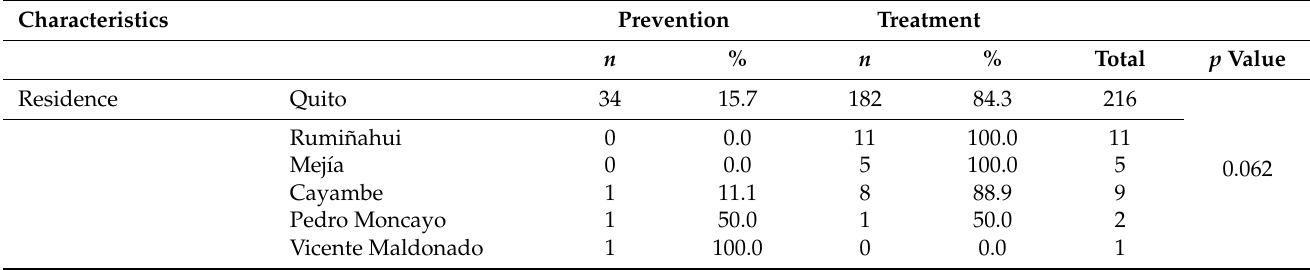
Table 2. Consumption pattern distribution according to the participant’s